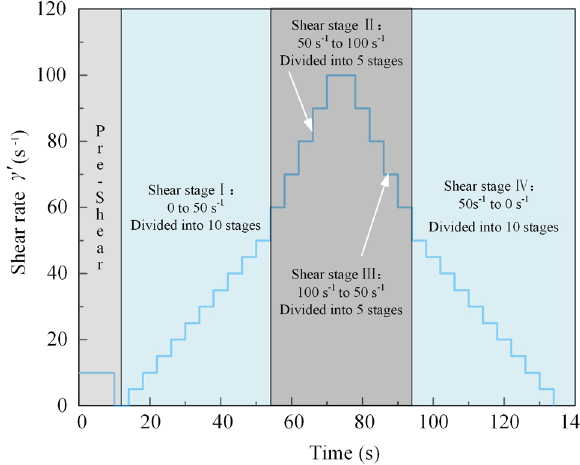
Figure 2: Protocol for rheology test of UHPC